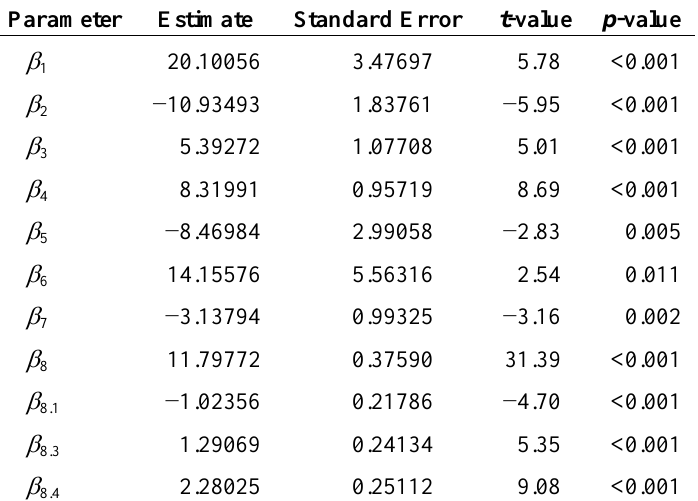
Table A2. Parameter estimates for the fixed independent variables of the NLME model for tree height (Equation (A1)).